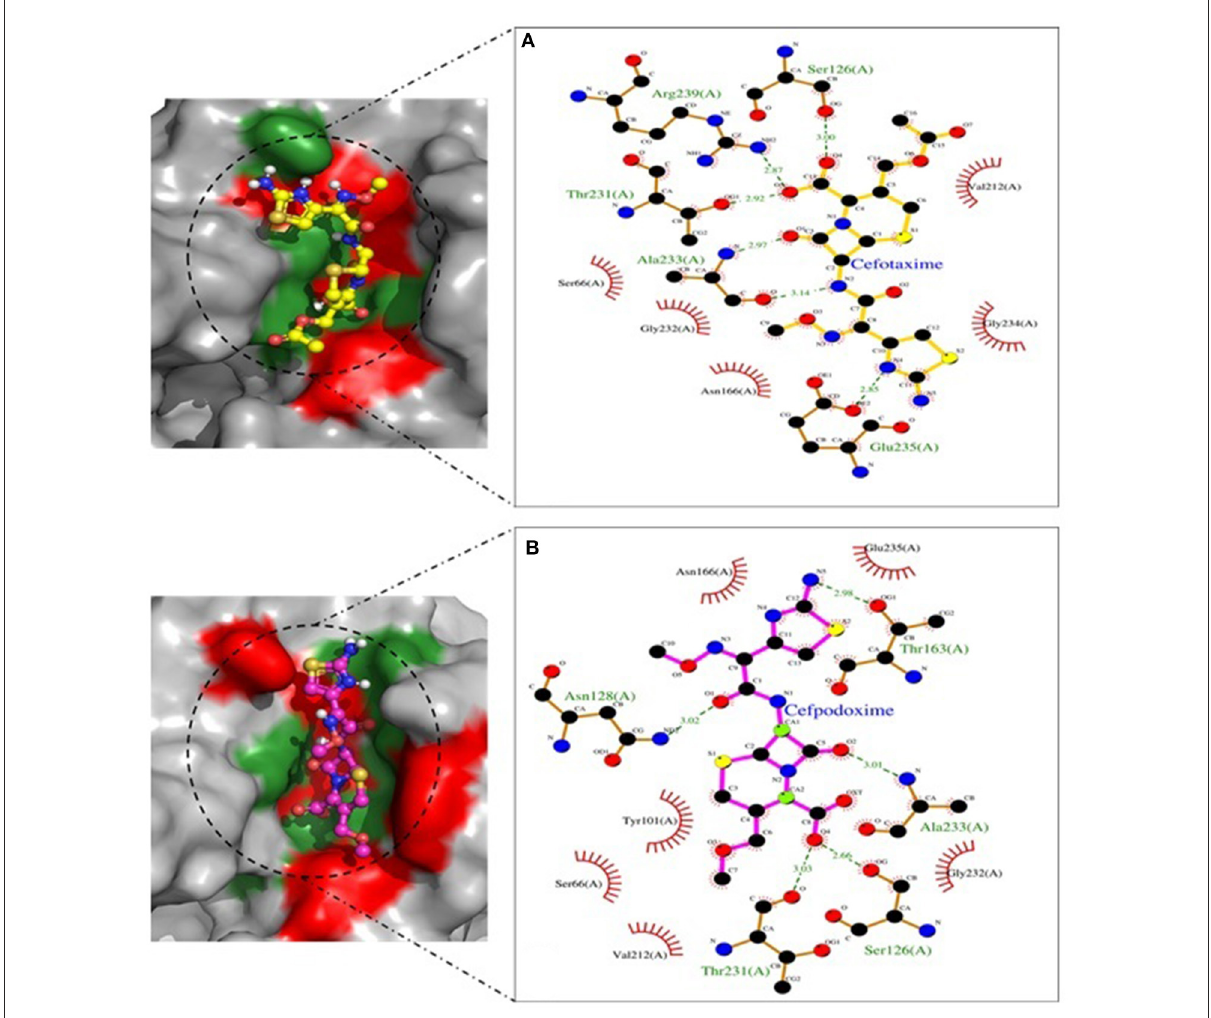
FIGURE9 SHV-228 involved in interactions. (A) A binding map for cefotaxime + SHV-228. (B) A binding map for cefpodoxime +